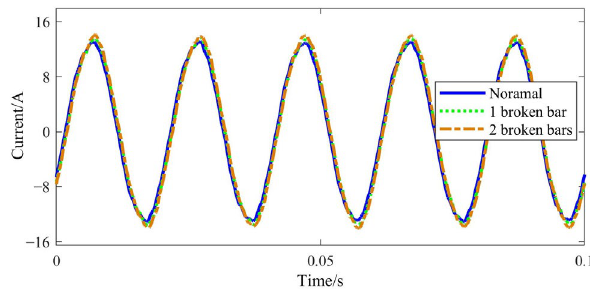
Figure 17. Stator current time-domain signal.